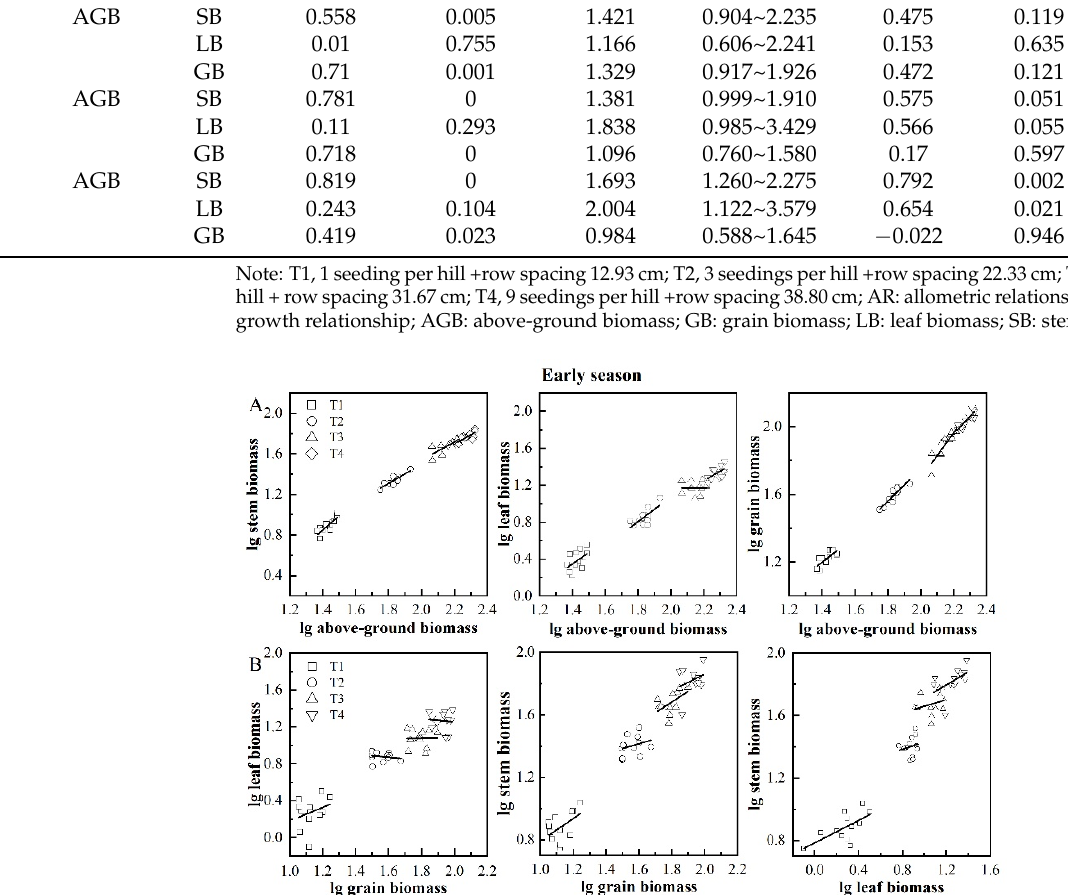
Table 4. Test of allometric growth between the aboveground biomass and organ biomass in early and late season rice.